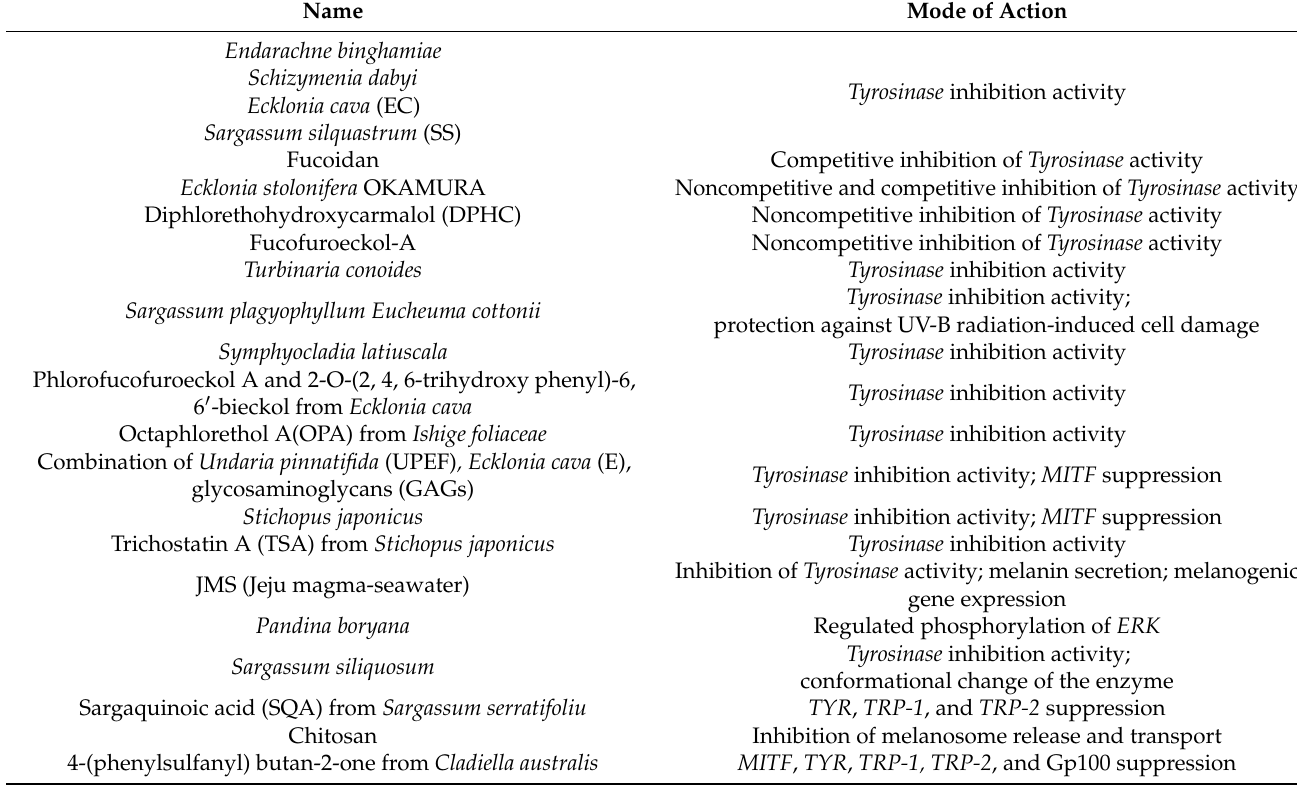
Table 2. List of skin-whitening agents derived from